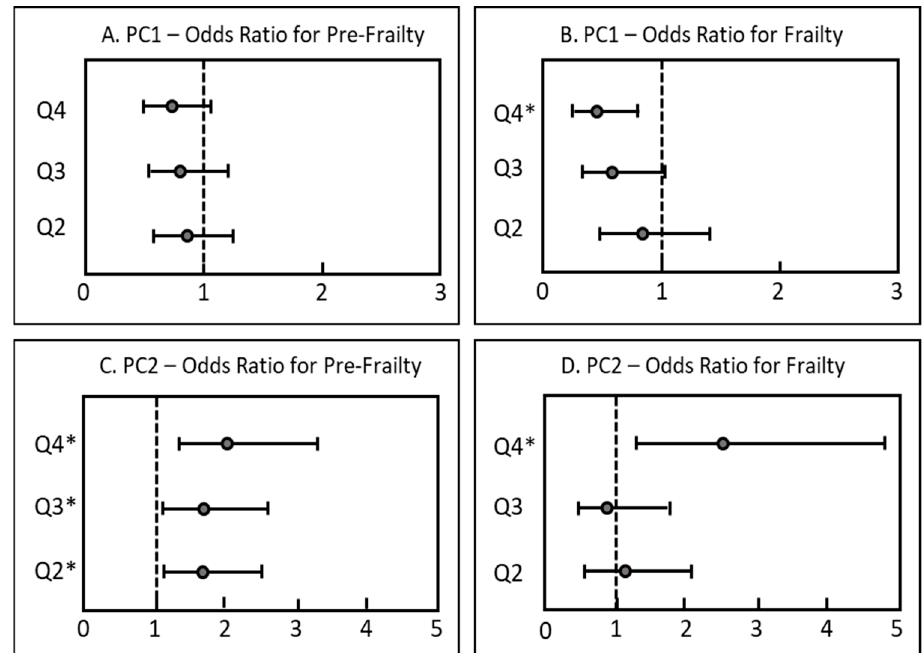
Figure 2. Cross-sectional associations between patterns of fat-soluble biomarkers (considered as quartiles) and frailty status in older adults ( n =1271). Results are displayed as odds ratios (OR with 95% CI). ORs were determined via multinomial regression analysis adjusted for season of blood sampling, sex, age, BMI, current smoking status, multimorbidity and cohort; the vertical line at OR = 1 represents the reference odds ratio to be considered robust; * p < 0.05. Q1 = reference